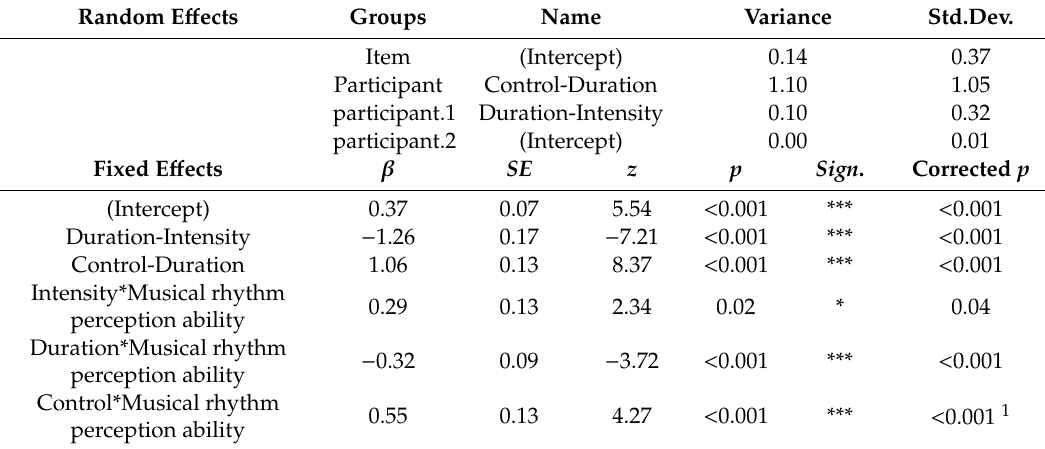
Table A6. Output of the second model exploring the e ff ects of musical rhythm perception ability on the three